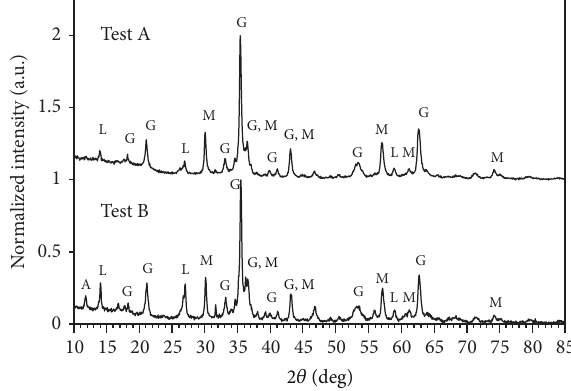
Figure 7: XRD patterns of specimens submitted to accelerated